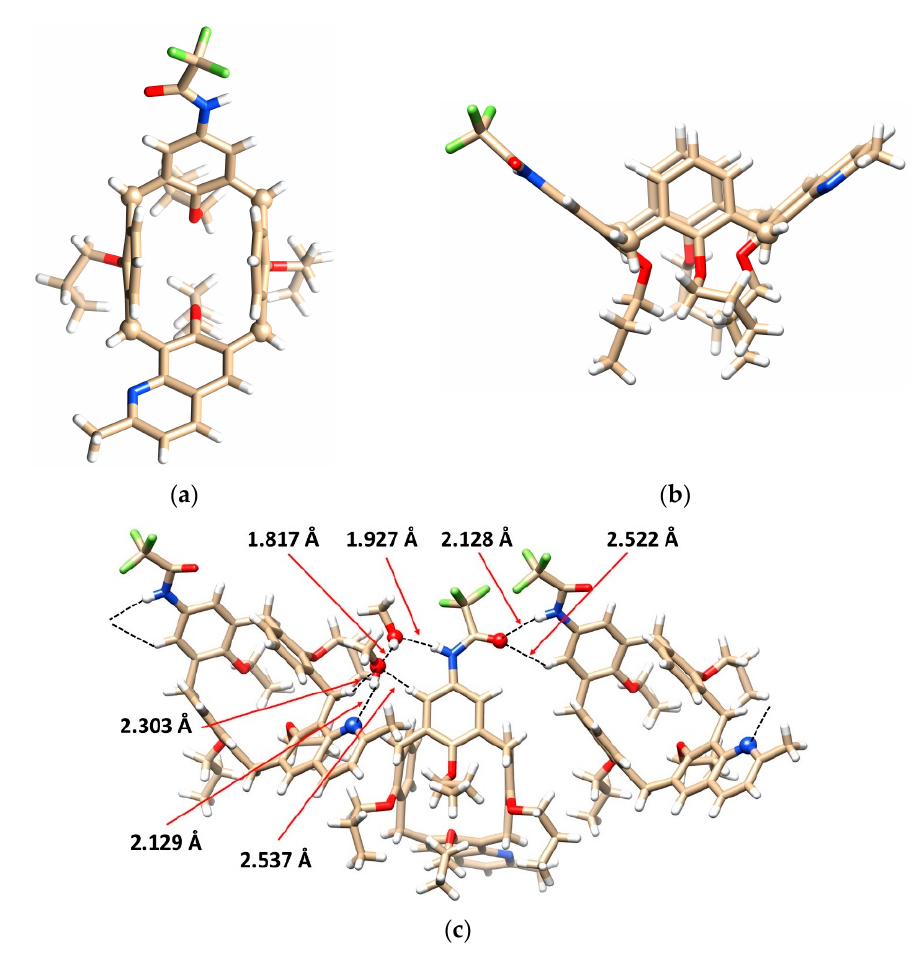
Figure 3. X-ray structure of 16 : ( a ) top view showing pinched cone conformation (bridging C atoms shown as balls for better clarity); ( b ) side view of the same; ( c ) the binding motif in crystal packing of enantiomers; methanol solvate was removed for better clarity.